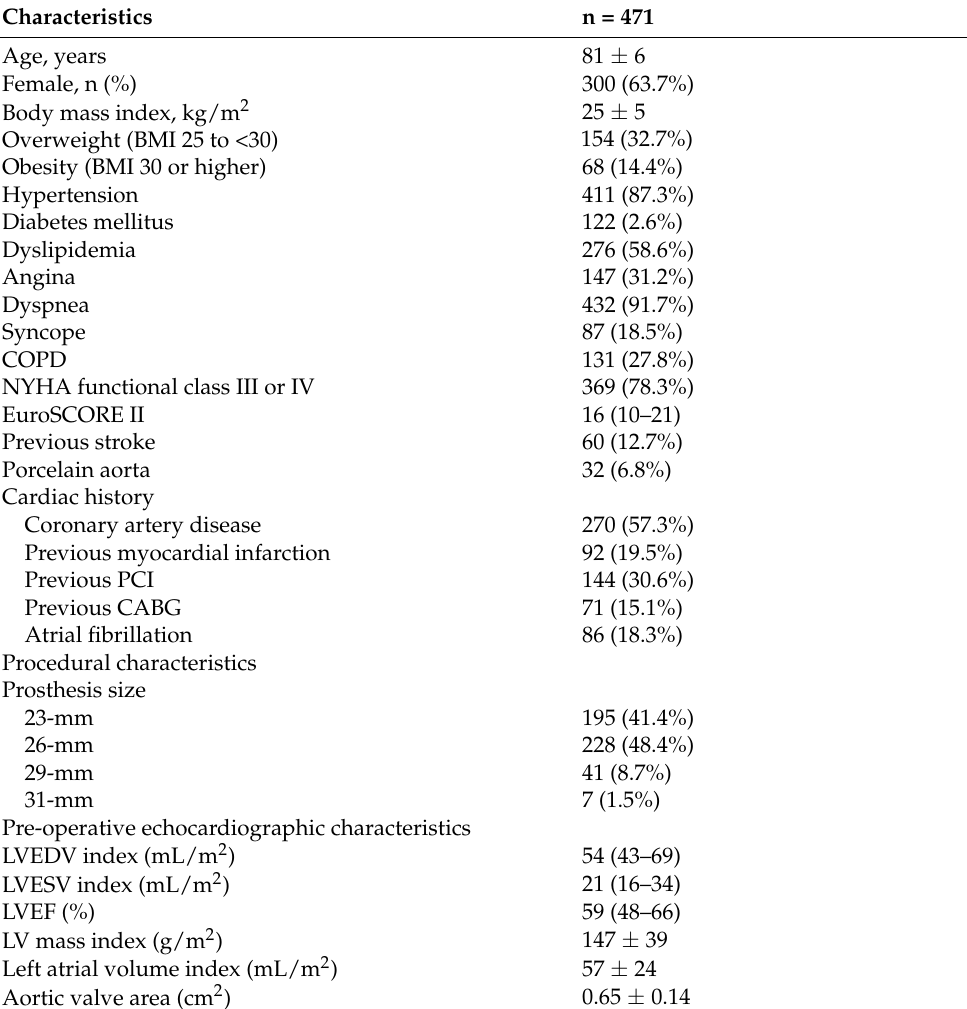
Table 1. Baseline characteristic of the